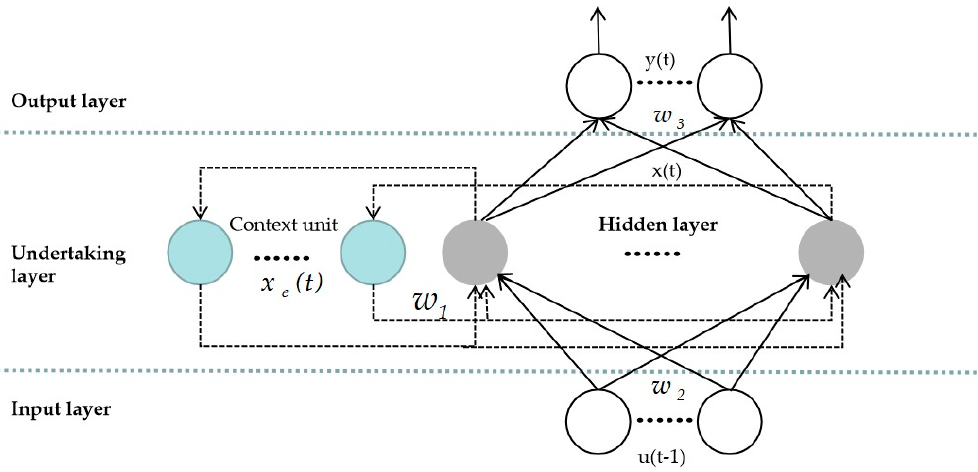
Figure 4. The network of Elman interval prediction.